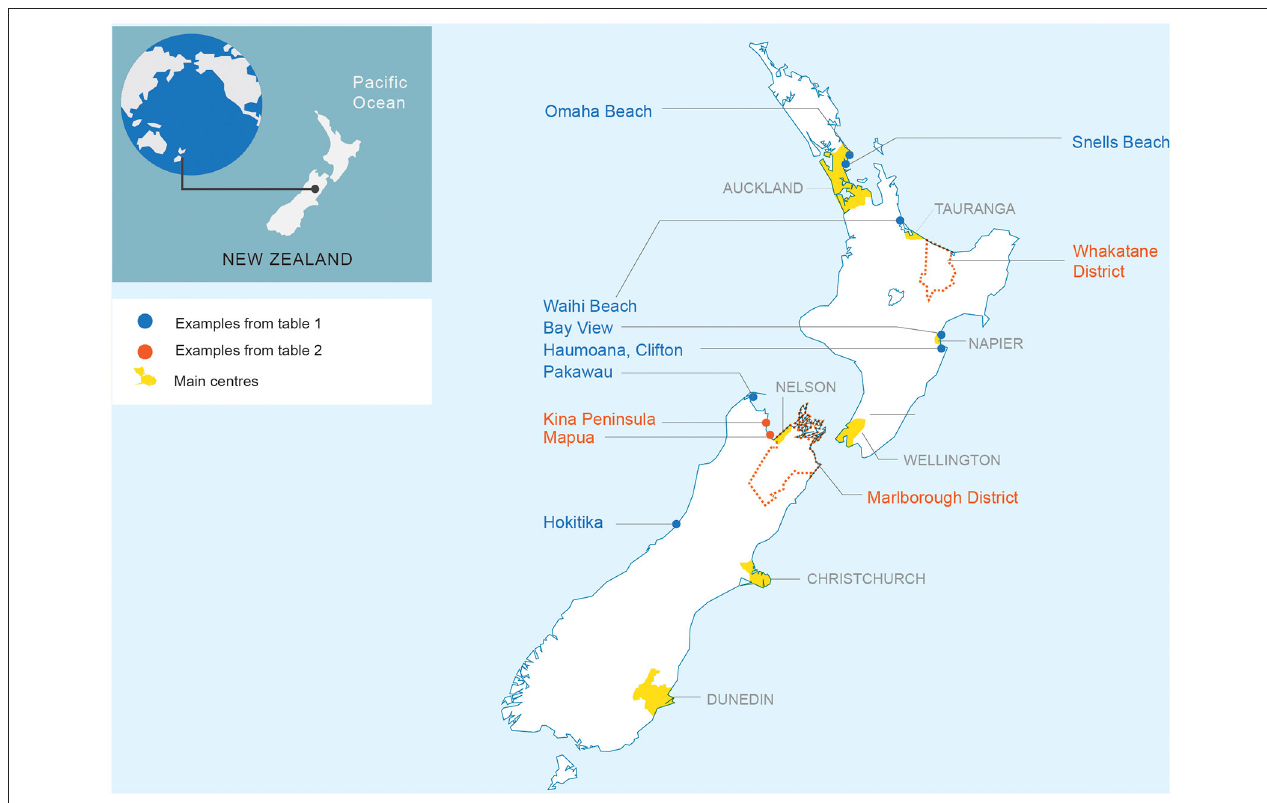
FIGURE 1 | Location of New Zealand and examples cited in Tables 1 , 2 .